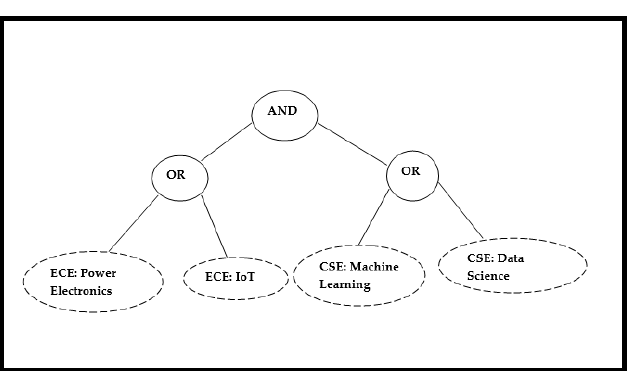
Figure 1. Public access policy.